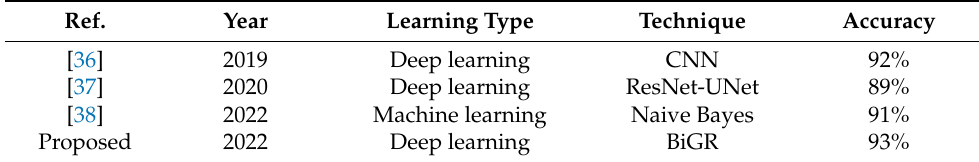
Table 12. The performance of the proposed approach with other state-of-the-art studies.